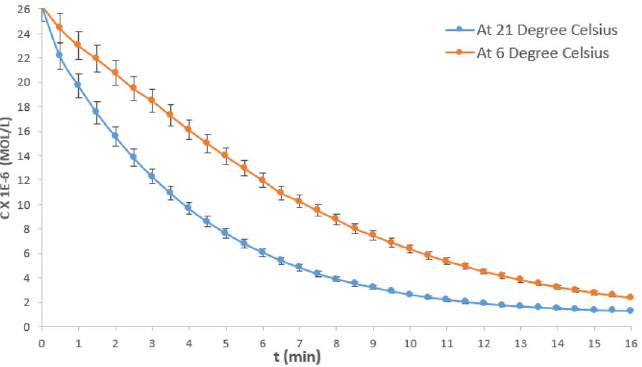
Figure 3. C–t curve for the hydrolysis of crystal violet at 0.016 M NaOH and variable